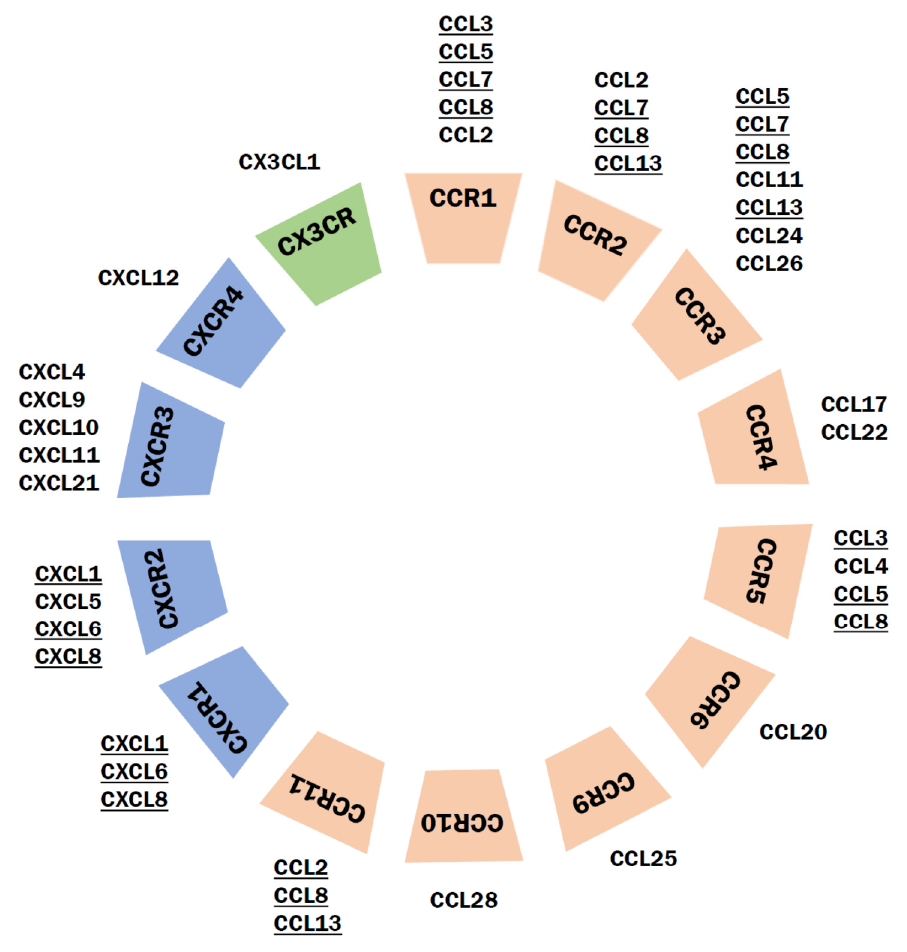
Figure 7. Chemokines and their receptors in schizophrenia. Some chemokines (underlined here) that are altered in schizophrenia can bind to multiple receptors and they all act through increasing calcium transients. Based on [10,11,261,264,267–269,275,281–293].